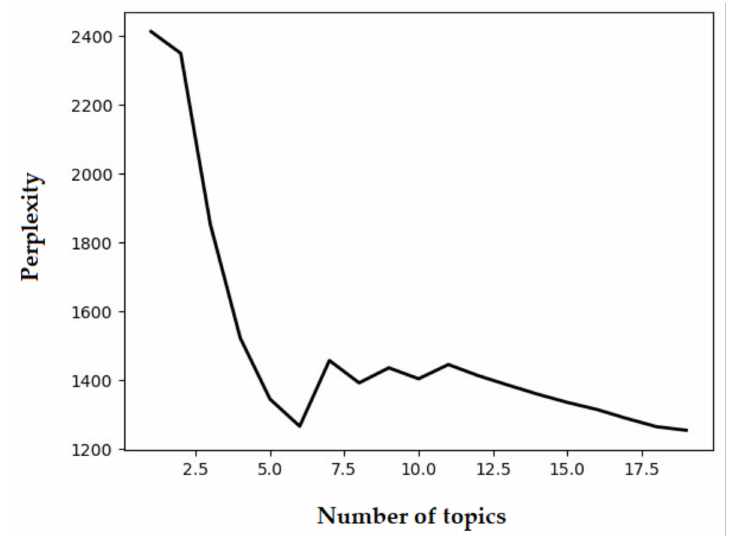
Figure 1. The perplexity of the topic